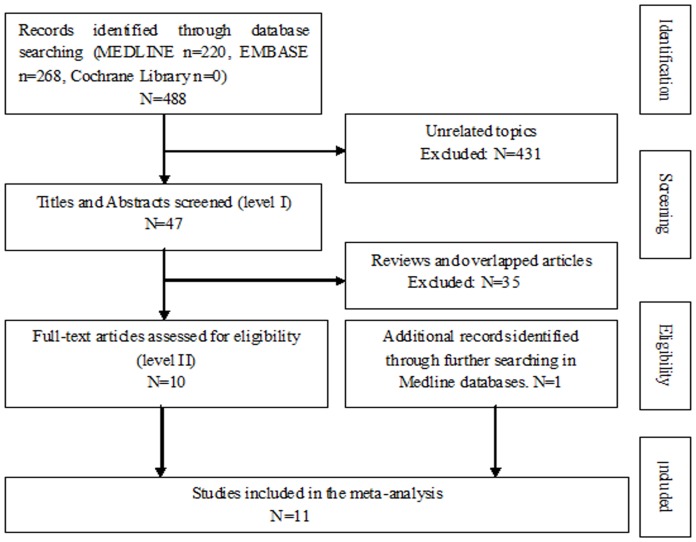
Flow diagram of our method of evidence.